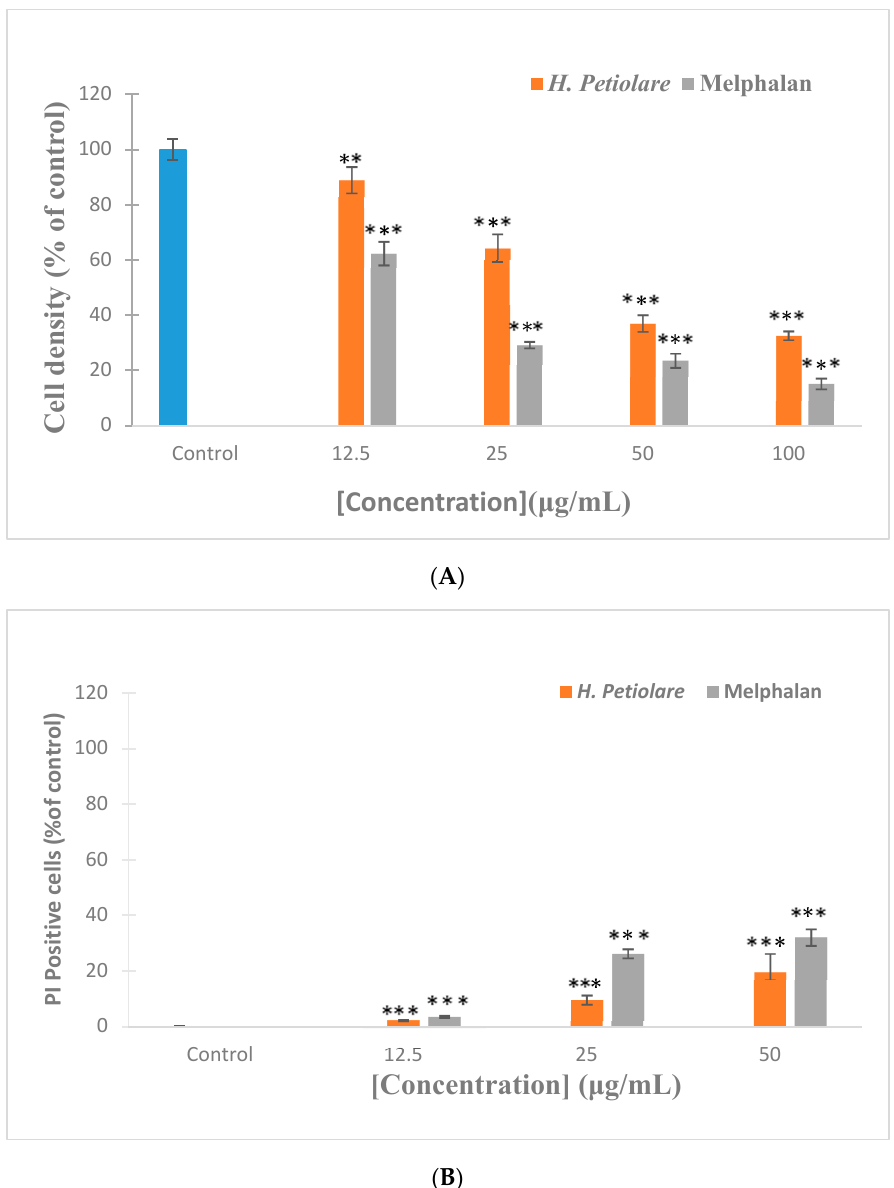
Figure 2. Cytotoxicity of H. petiolare methanol extract towards human melanoma cells (MeWo). ( A ) Cell density represents the number of nuclei stained with Hoechst and expressed as a percentage of the untreated control. ( B ) Cell death is quantified as the percentage cells which stain positive for PI. Melphalan included as a positive control. Data are expressed as the mean ± SD, n = 3. ** p < 0.01 and *** p < 0.001 compared to